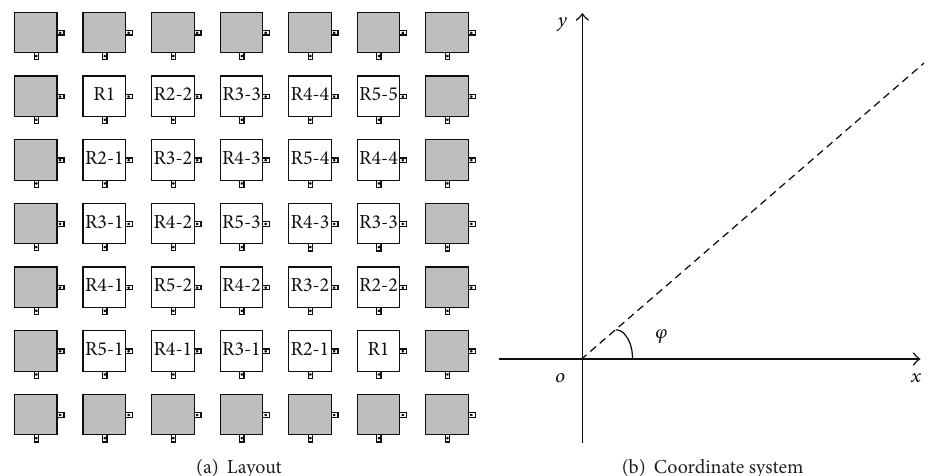
Figure 2: Topology of the small array (the outermost elements with gray color indicate passive elements terminated with 50 Ω matched loads).